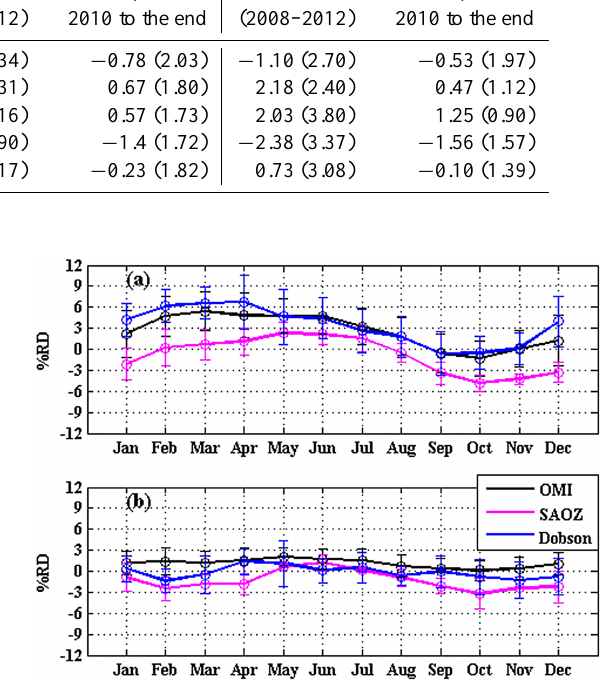
Table 2. Seasonal biases observed between IASI and the other instruments (OMI, Dobson and SAOZ), merged for all sites. % bias (1 σ ) OMI DOBSON SAOZ All data